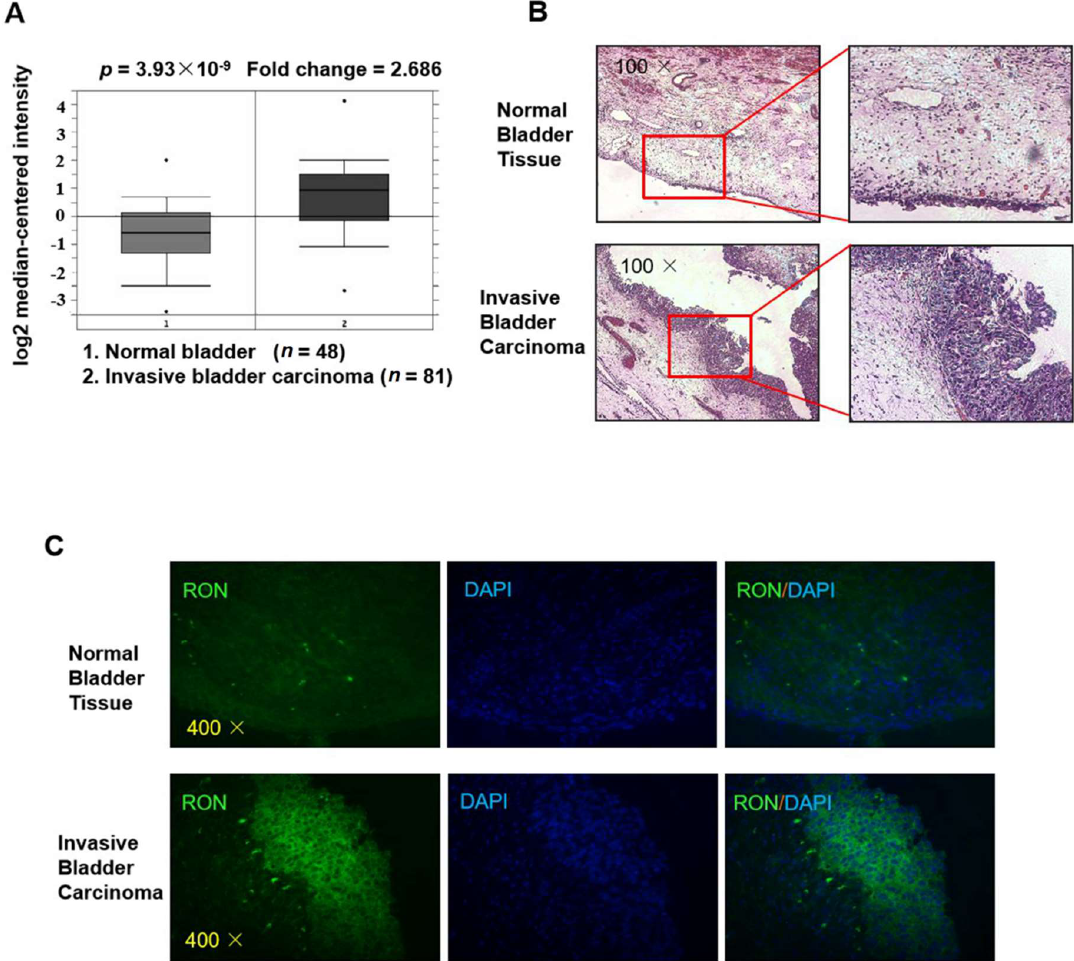
Figure 1. RON expression is higher in invasive bladder cancer than in normal bladder tissue. ( A ) The expression level of RON from a clinical sample database (https://www.oncomine.org). ( B ) H&E staining of normal bladder tissue (upper) and invasive bladder carcinoma (lower) sections. The photographs were taken under a microscope at 100× magnification. ( C ) Immunofluorescence staining was performed to detect RON protein in normal bladder and invasive bladder carcinoma tissue. RON positive cells were stained green, and the nuclei were stained blue. The photographs were taken with a fluorescence microscope at 400× magnification.